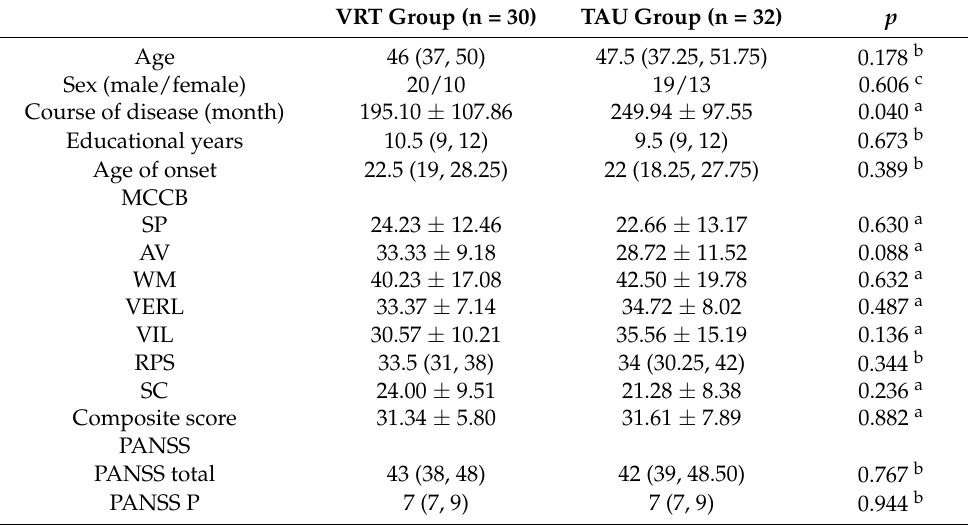
Table 1. Demographic characteristics and baseline data of the two